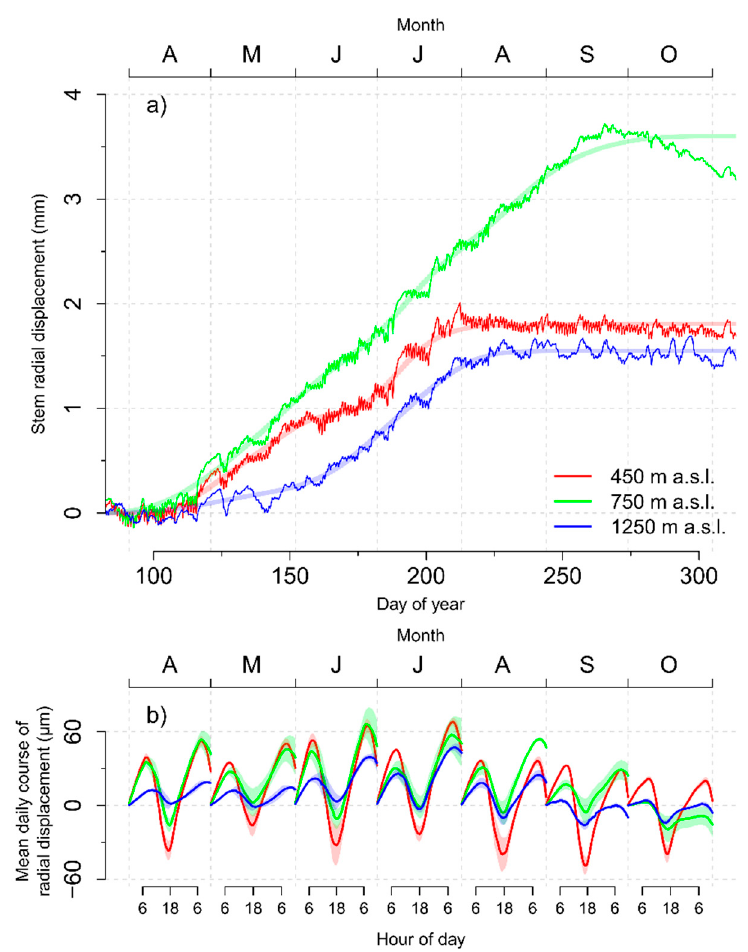
Figure 6. ( a ) Seasonal variation of cumulative stem radial displacement with fits of shape constrained additive models and ( b ) mean daily course of stem radial displacement of trees growing at 450 m, 750 m, and 1250 m a.s.l. elevation, respectively. Transparent ribbons indicate the standard error of the estimate.